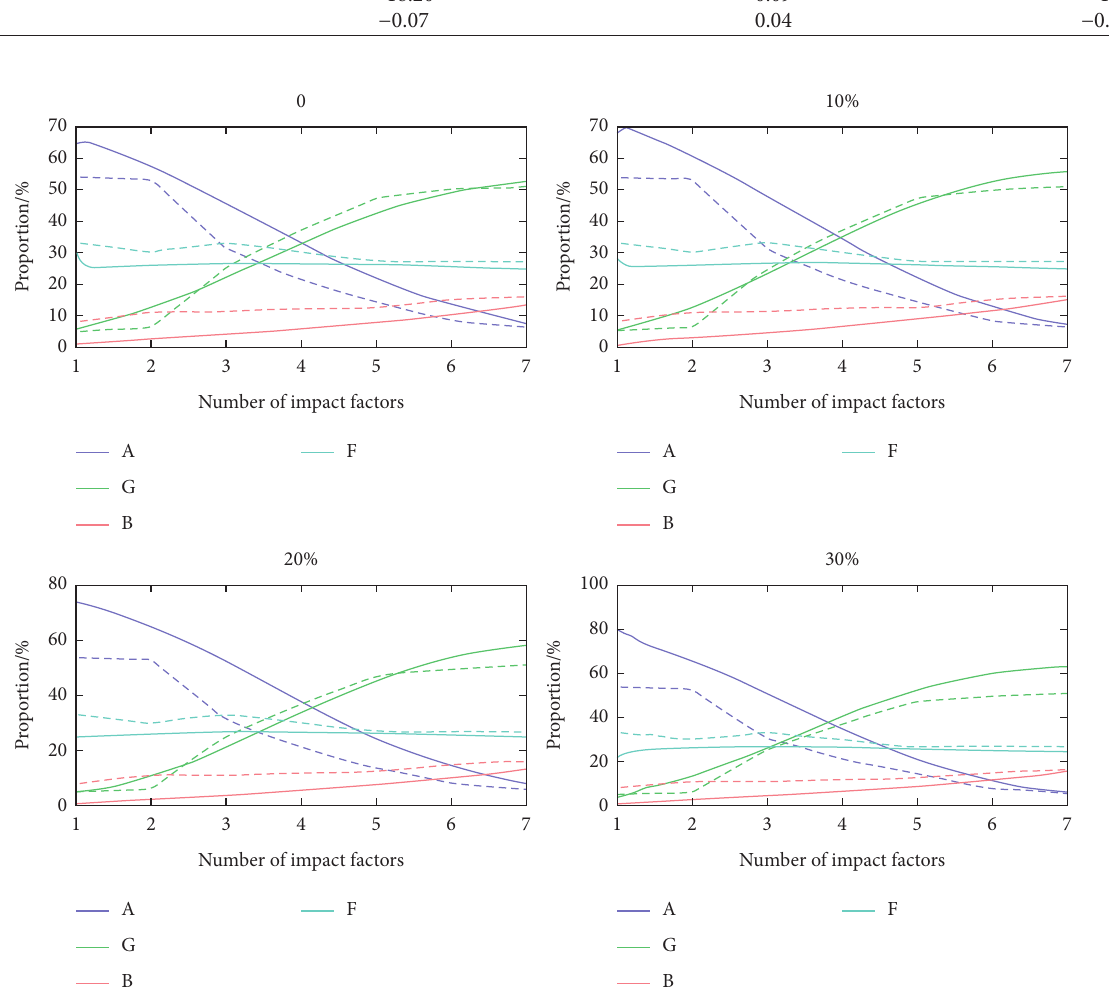
Figure 5: Performance of the test using Minimax-FCM on